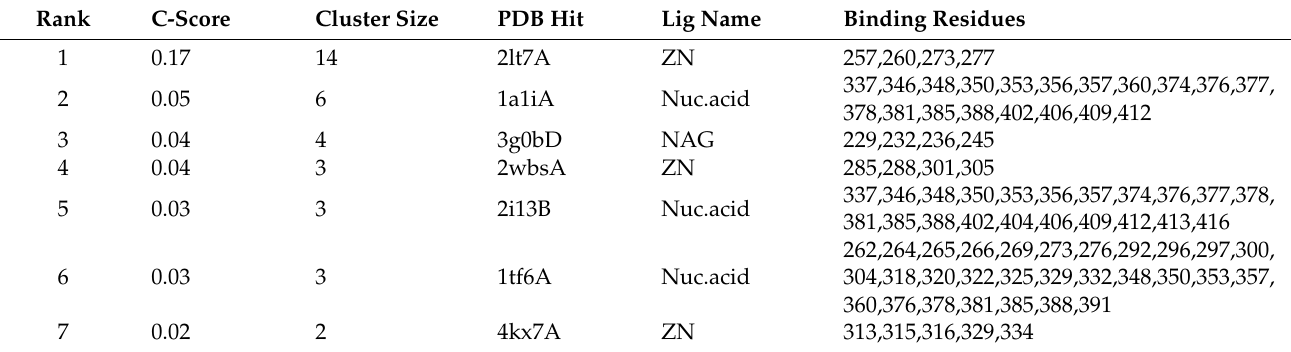
Table 2. Ligands and binding residues of human ZNF141